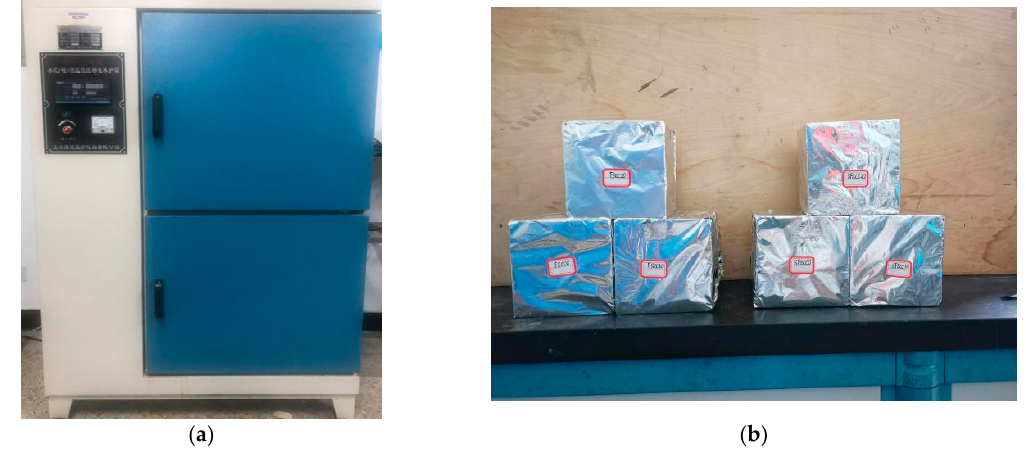
Figure 6. ( a ) Standard curing. ( b ) Tinfoil wrapping curing.